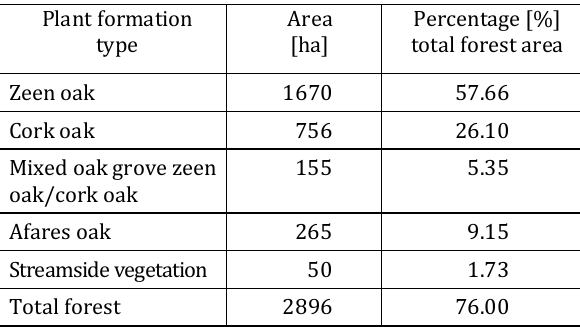
Table 1. Areas for each plant formation type Plant